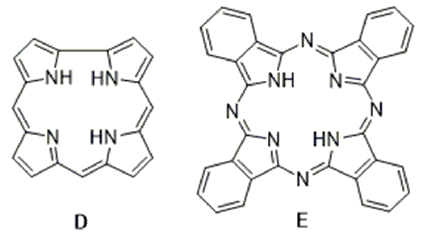
Figure 5 - Corrole ( D ) and Phthalocyanine ( E )